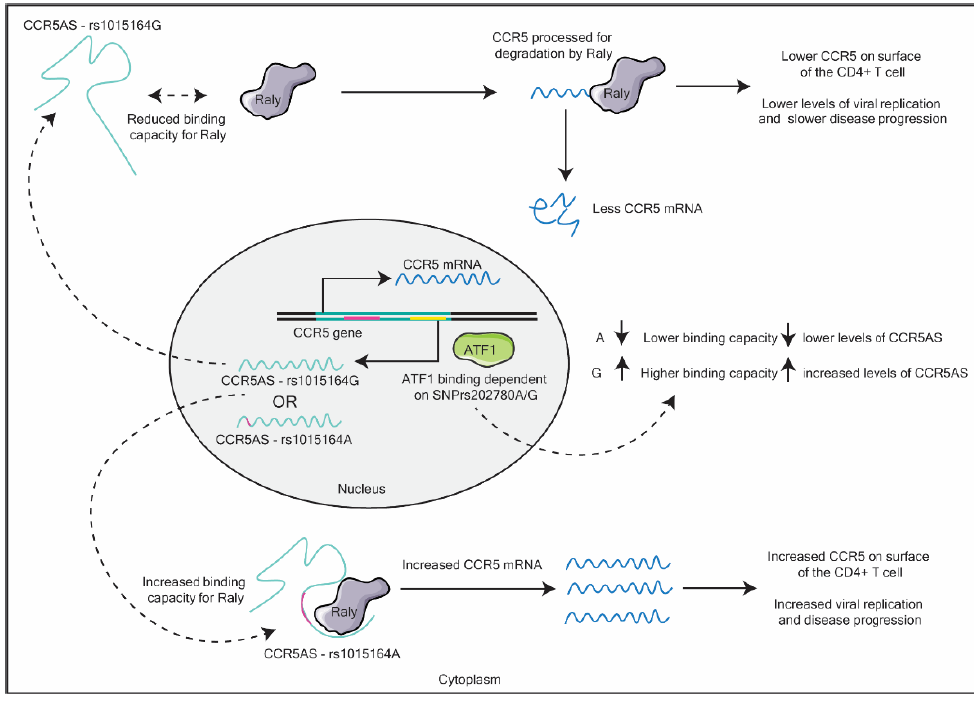
Figure 4. Schematic detailing the effects SNPs rs1015164(A/G) and rs202780(A/G) in the C-C chemokine receptor 5 antisense ( CCR5AS ) gene have on subsequent C-C chemokine receptor 5 (CCR5) mRNA levels. See text for details.